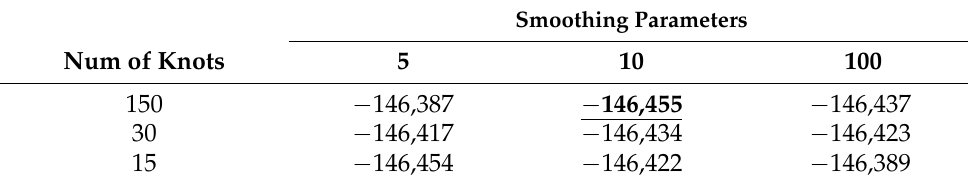
Table 3. DIC for Gamma distribution (4 January 2016, TMC, Aichi, Japan).